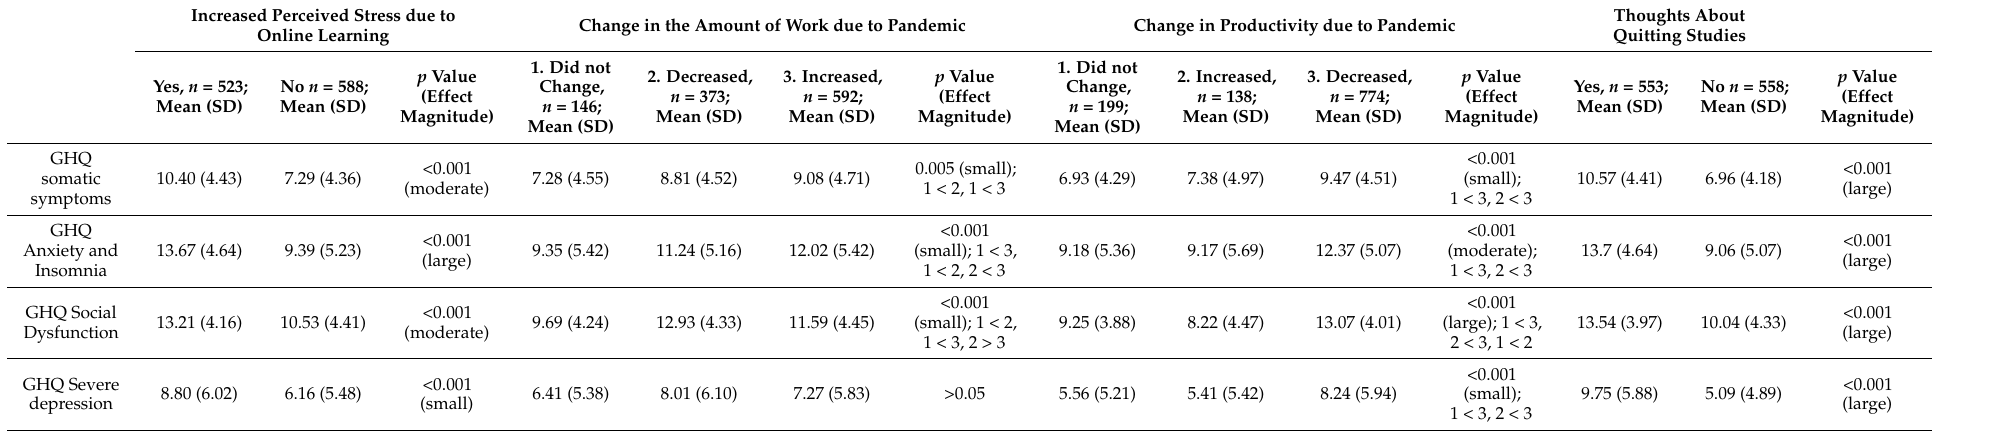
Table 2. Aspects of studying and their impact on Global Health Questionnaire (GHQ) scores. SD—standard